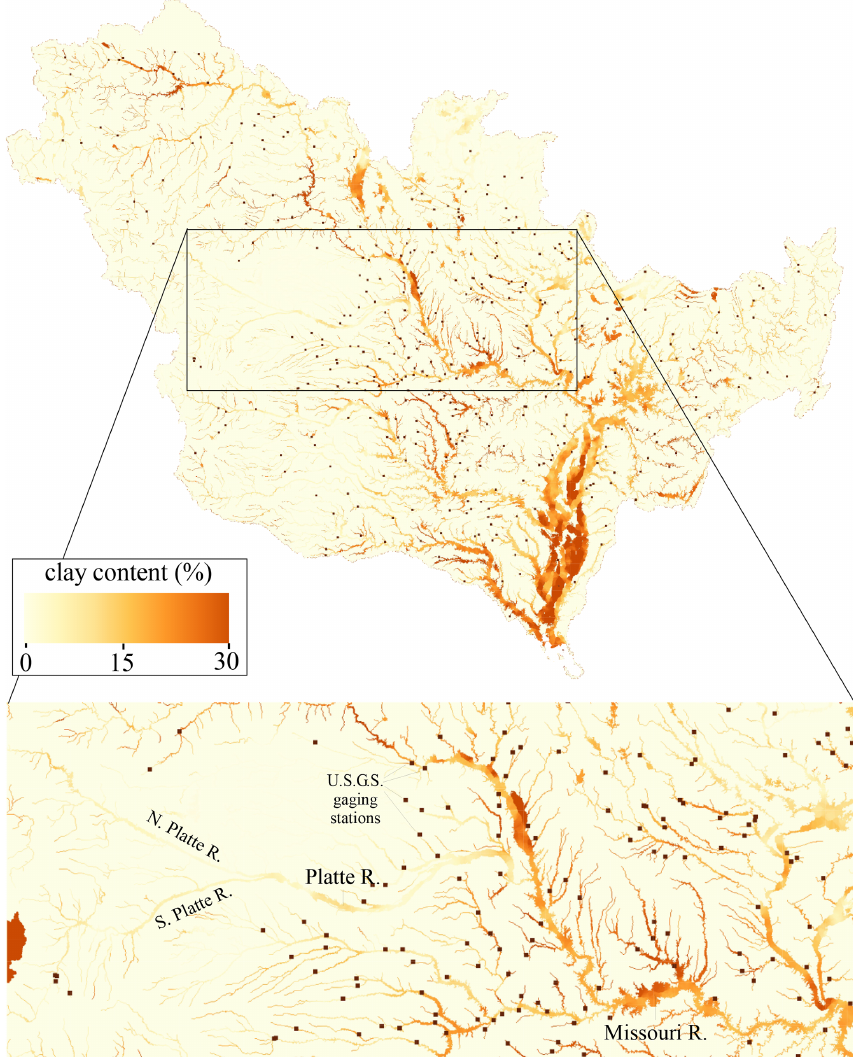
Figure 1. Color map of the average floodplain deposit clay content in the Mississippi River basin. Also shown are the locations of the 387 USGS gaging stations where predicted bank-full depths were computed using Eq. (5) and the observed bank-full depths were estimated based on the bends in the stage–discharge rating